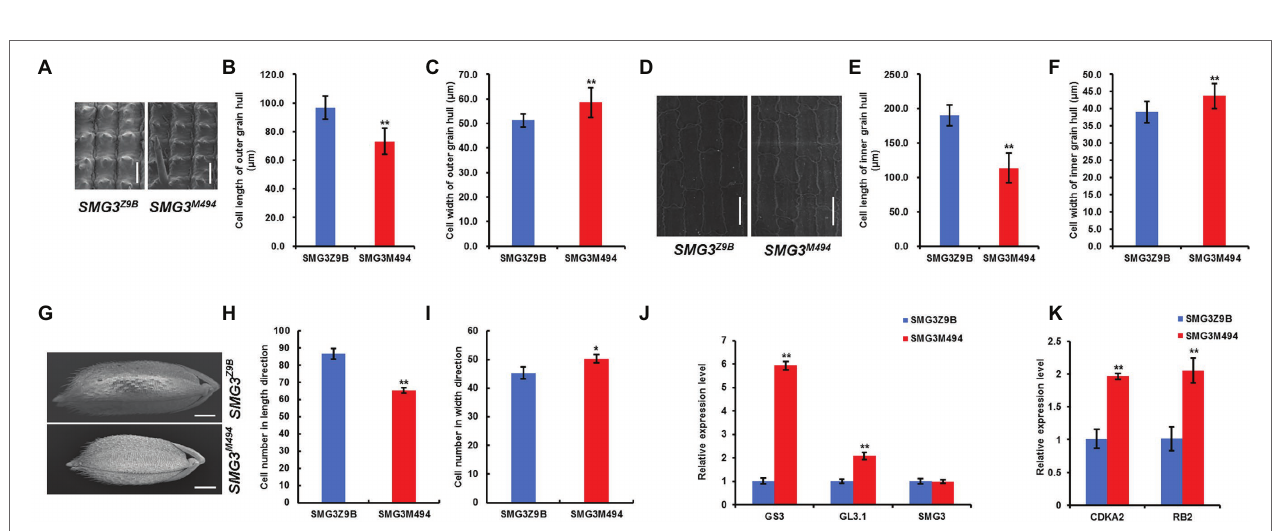
FIGURE 4 | Histological and qPCR analysis between NIL- SMG3 Z9B and NIL- SMG3 M494 . (A) Scanning electron microscope analysis of the outer surfaces of the grain hulls in SMG3 Z9B and SMG3 M494 . Scale bar: 50 μ m. (B,C) The average length and width of outer epidermal cells. (D) Scanning electron microscope analysis of the inner surfaces of the grain hulls in NIL- SMG3 Z9B and NIL- SMG3 M494 . Scale bar: 50 μ m. (E,F) The average length and width of inner epidermal cells. (G) Scanning electron micrographs of the outer surfaces of glumes in NIL- SMG3 Z9B and NIL- SMG3 M494 . Scale bar: 1 mm. (H,I) the cell number in the outer glumes along the length and width direction between NIL- SMG3 Z9B and NIL- SMG3 M494 . (J) qPCR analysis of GS3 , GL3.1, and SMG3 genes in the NIL- SMG3 Z9B and NIL- SMG3 M494 . (K) qPCR analysis of CDKA2 and RB2 genes between NIL- SMG3 Z9B and NIL- SMG3 M494 . Data are given as means ± SD. * and ** indicate p < 0.05 and p < 0.01 by Student’s t